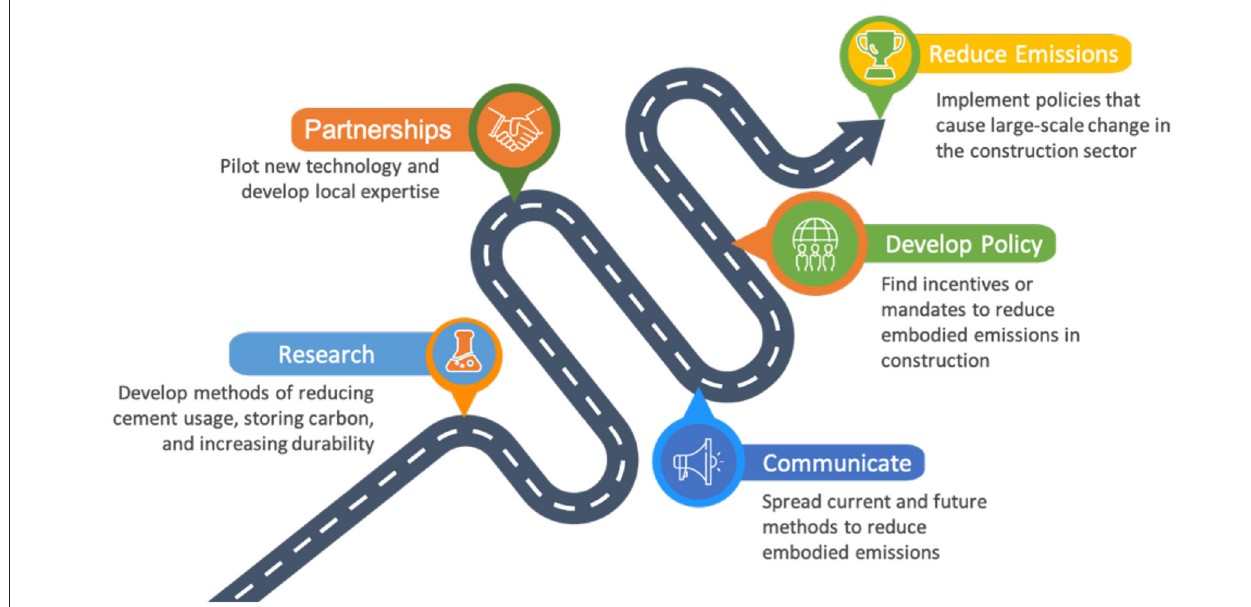
FIGURE 1 | Roadmap to reducing embodied emissions in